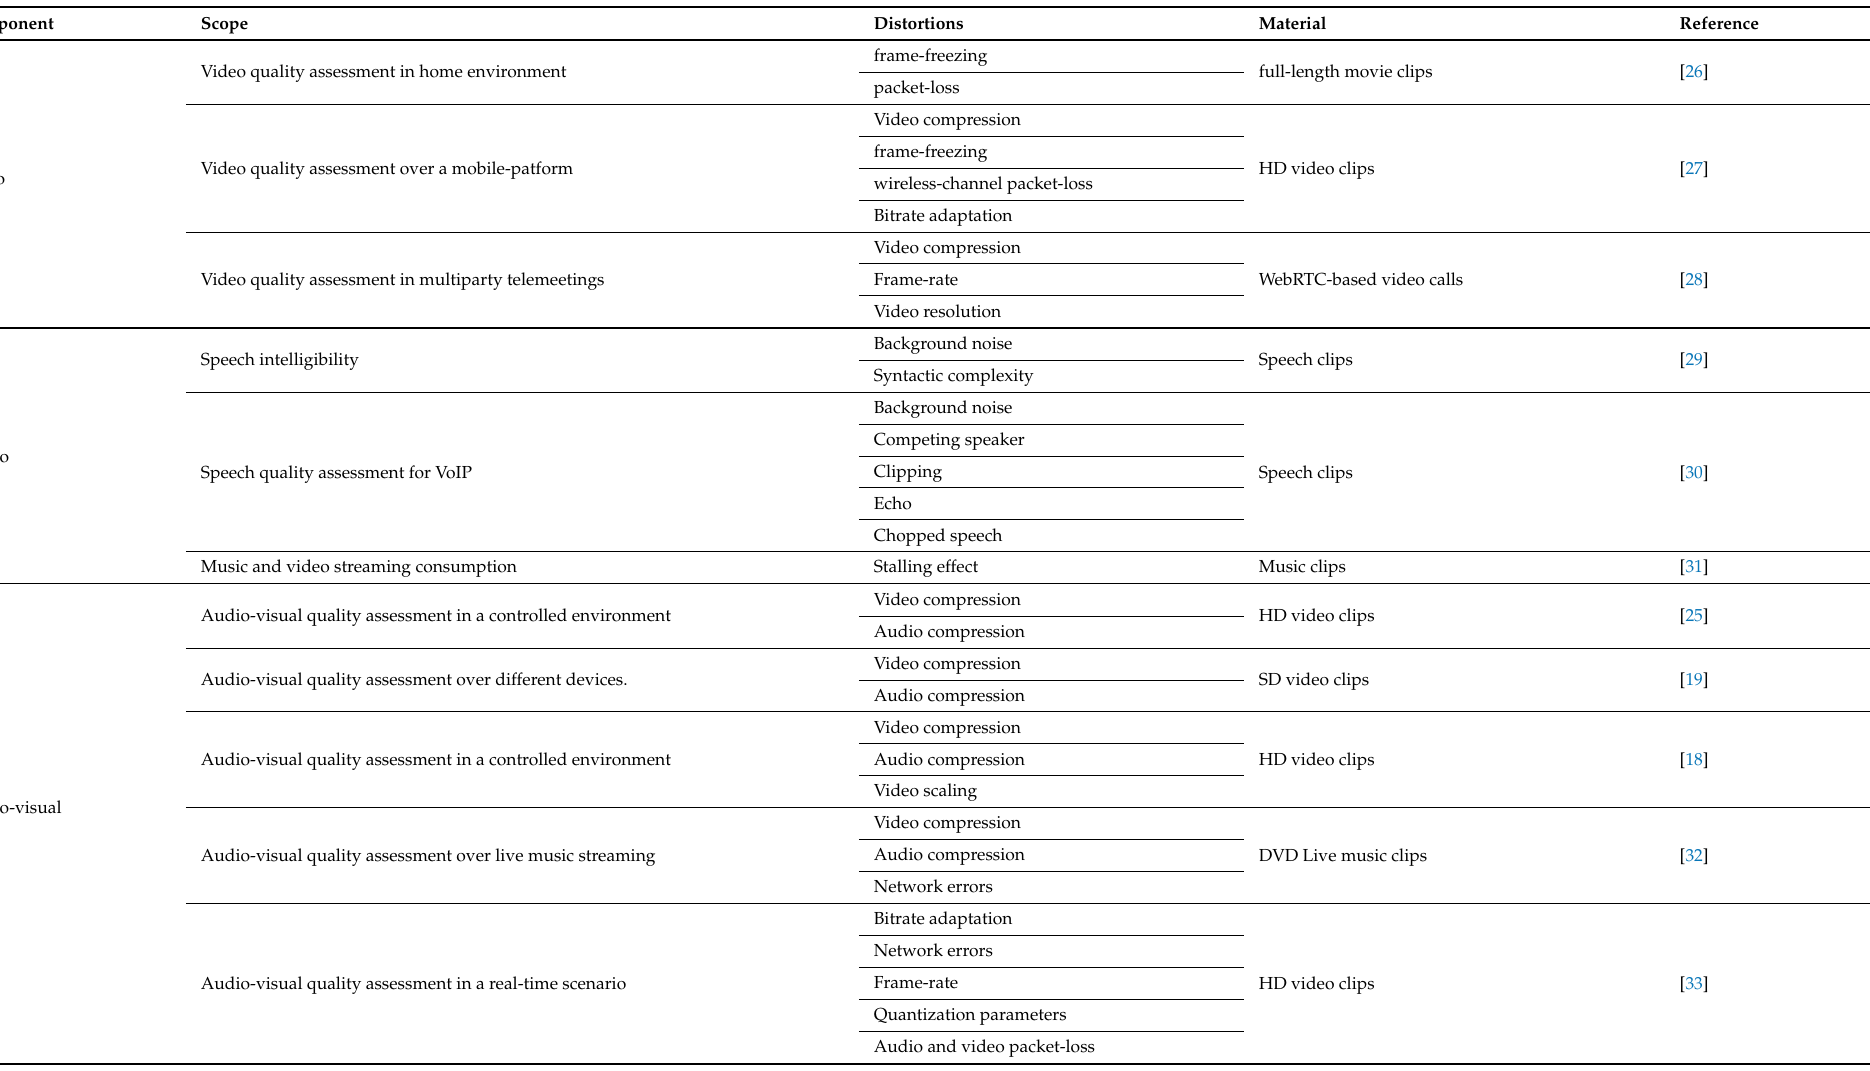
Table 1. Summary of subjective studies listed in Section